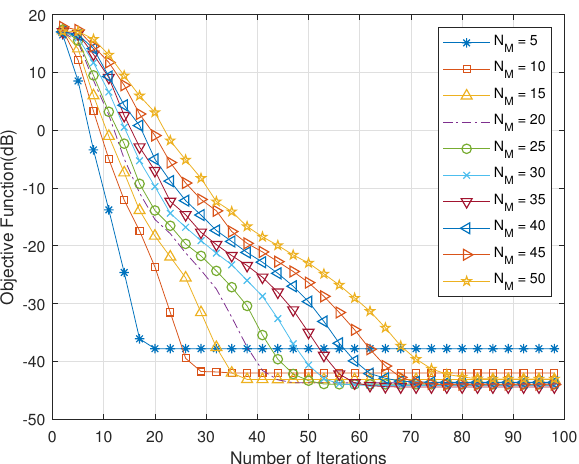
Figure 4. The relationship between the number of iterations and the objective